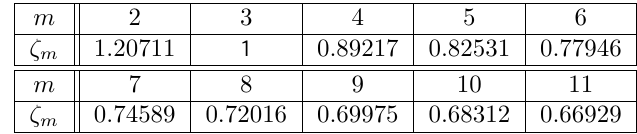
Tab. 1: Approximate numeric values of ζ m , the positive zeros of the equation 2 m ( z + 1 2 , . . . , 11